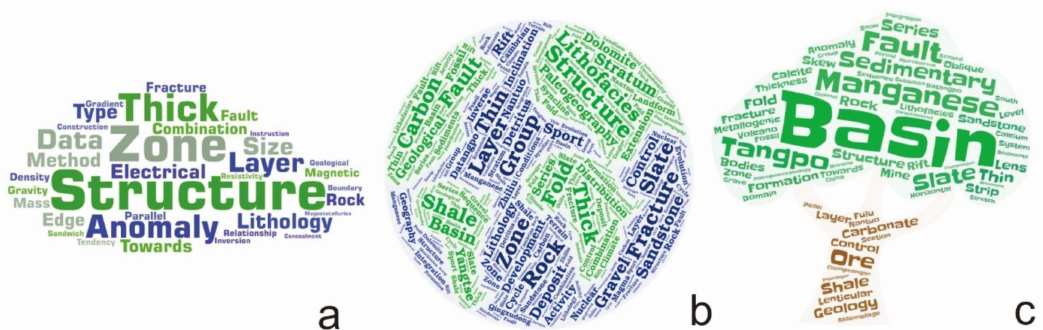
Figure 3. Examples of the word cloud in different shapes: ( a ) geophysical prospecting; ( b ) geological prospecting; ( c ) metallogenic